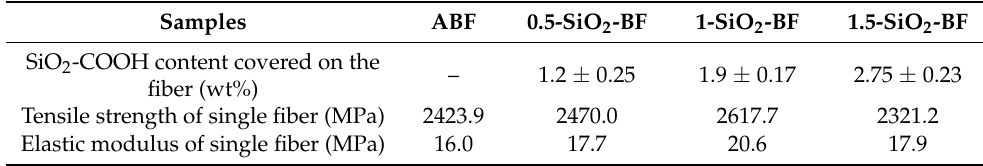
Figure 4. SEM images of different BF surfaces: ( a ) ABF, ( b ) 0.5-SiO 2 -BF, ( c )1-SiO 2 -BF, ( d ) 1.5-SiO 2 -BF. Table 3. Adhesion efficiency of SiO 2 -COOH on fiber surface.